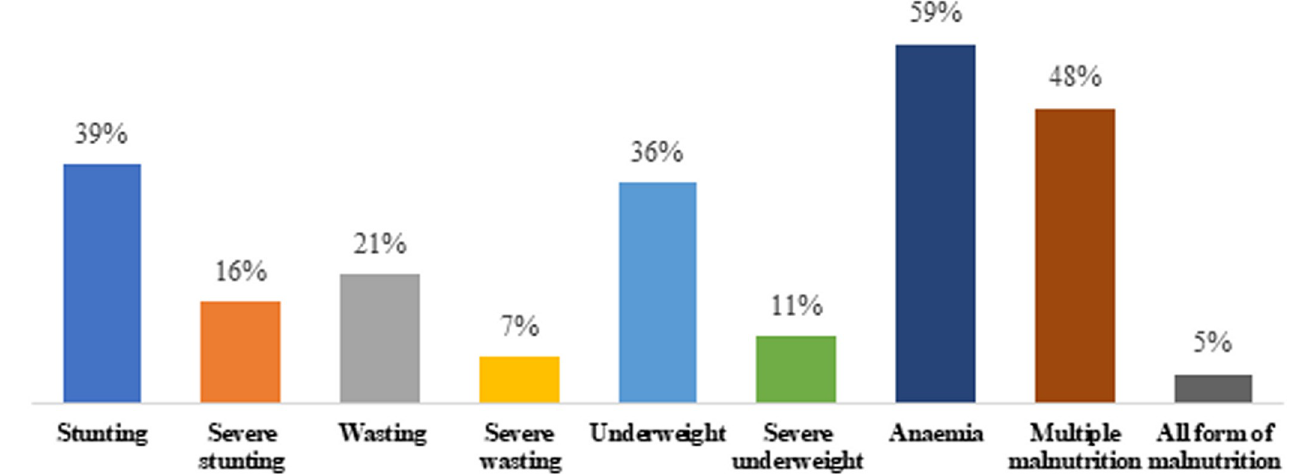
Fig 1. Prevalence of various nutritional status indicators among children aged five or below.